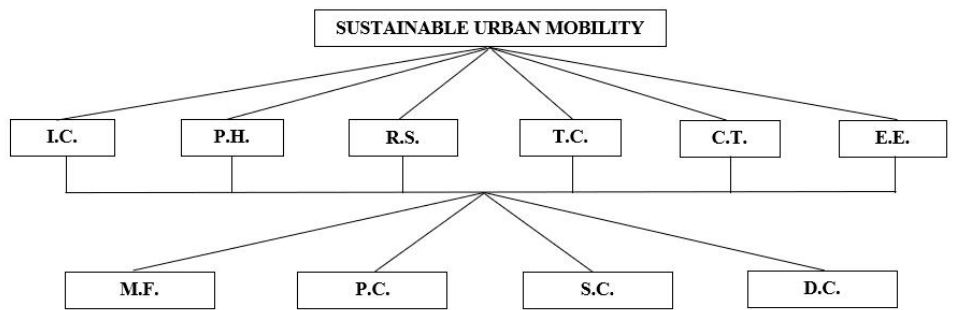
Figure 1. Hierarchy structure of the decision problem.